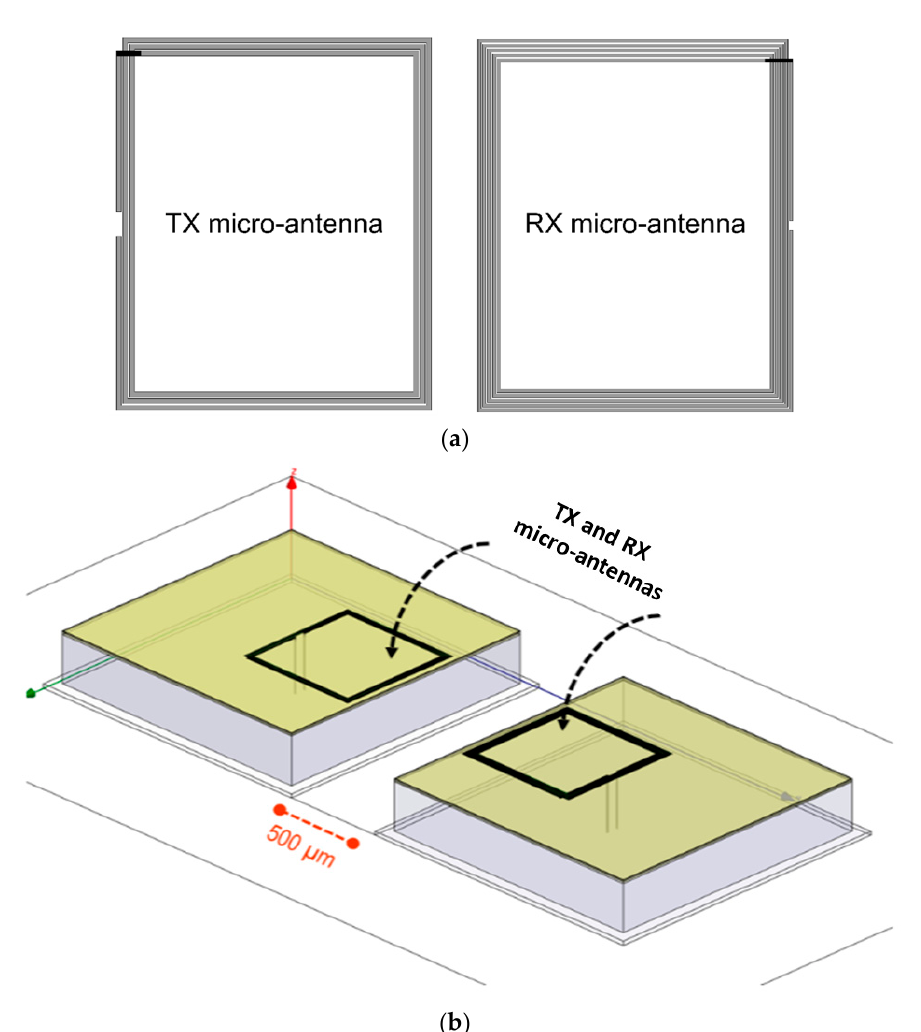
Figure 6. (a) Layout of the micro-antennas of Table 1; (b) 3D EM simulations of the micro-antennas.